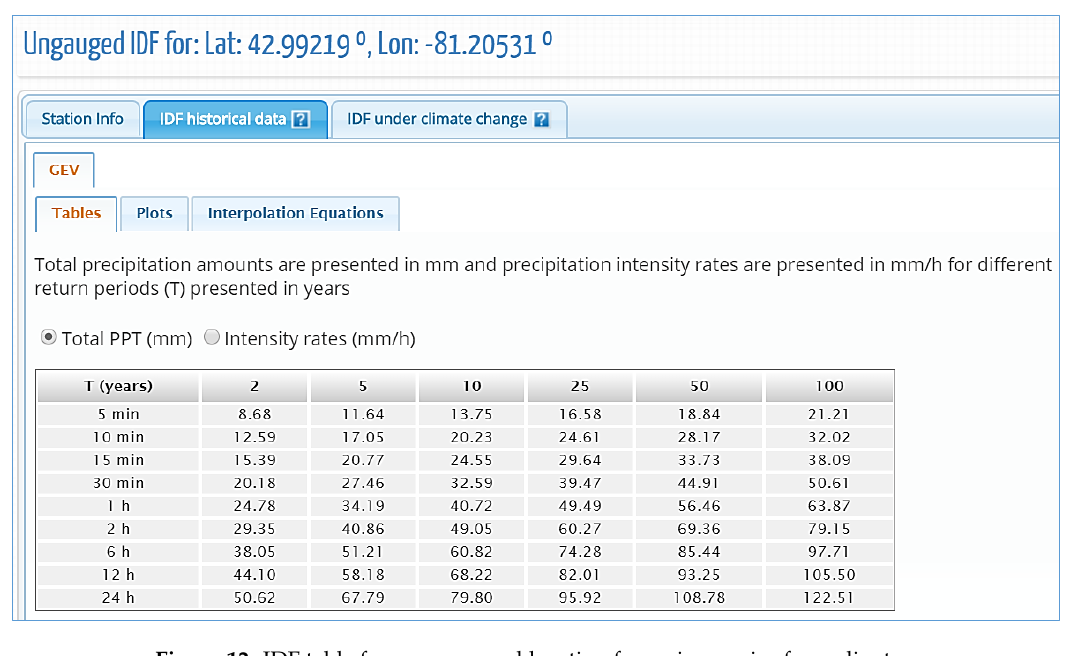
Figure 11. Various ungauged locations selected by the user.